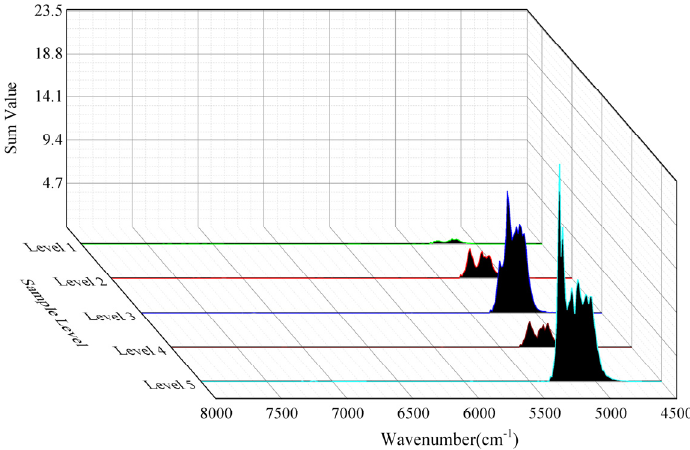
Figure 9. Difference spectrum distribution diagram of each level sample.